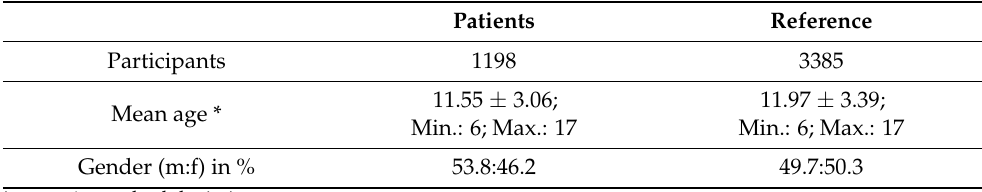
Table 1. Age and gender of patients and the reference